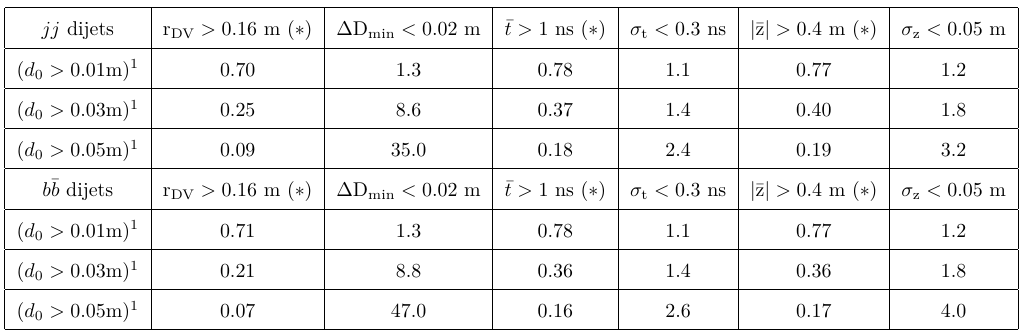
Table 1 . The correlations ρ ( vertexing-cuts , d 0 ) for QCD jj and b ¯ b backgrounds. The columns with ( ∗ ) are not used to calculate the final selection